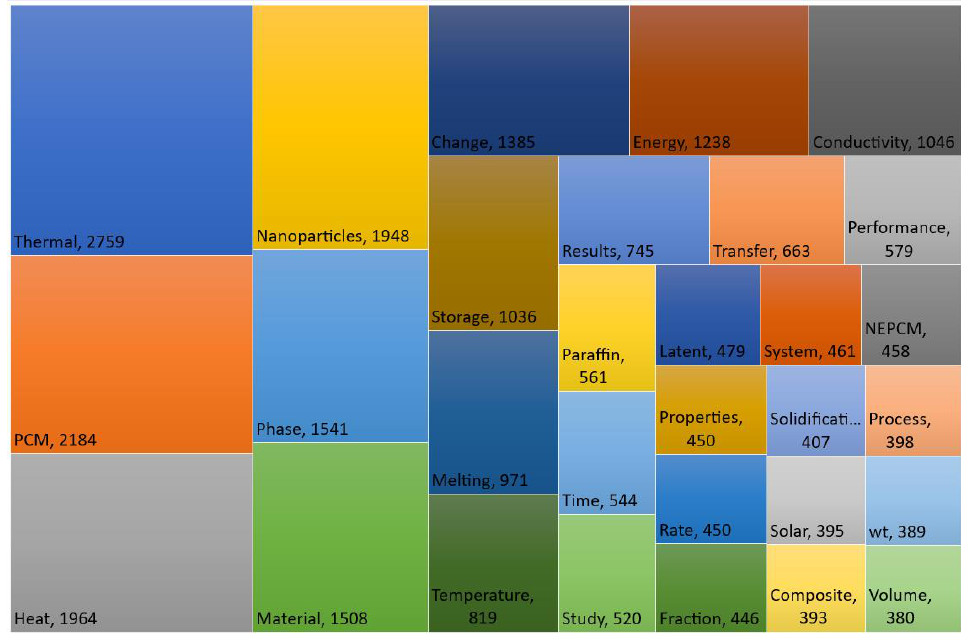
Figure 6. Treemap of 30 most frequent words in abstracts with the minimum occurrence of 380.